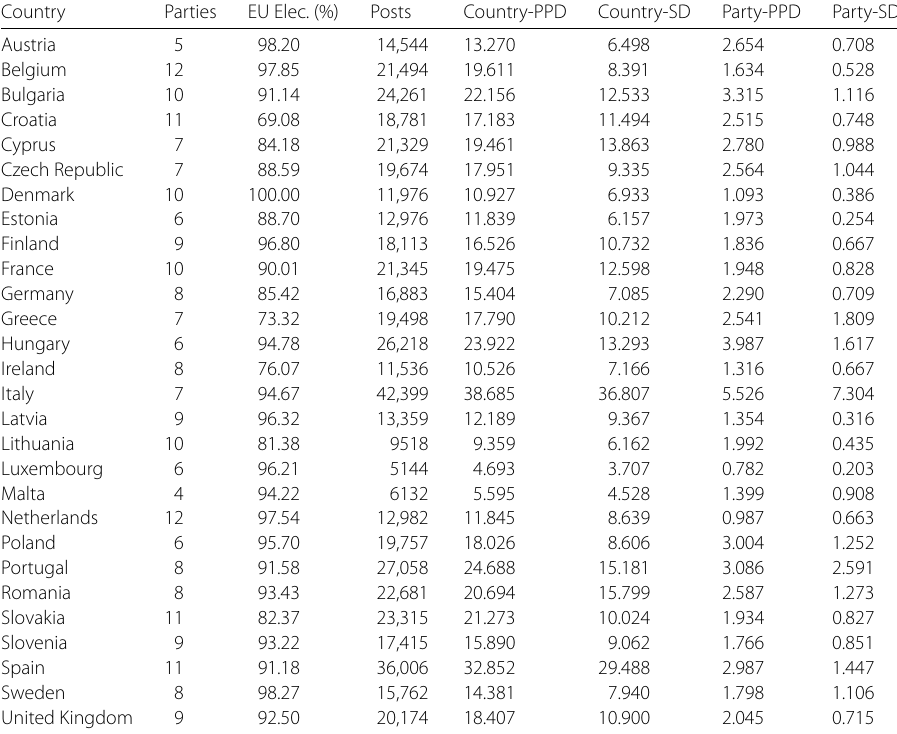
Table 1 Number of posts and political parties in our dataset from each country Country Parties EU Elec. (%) Posts Country-PPD